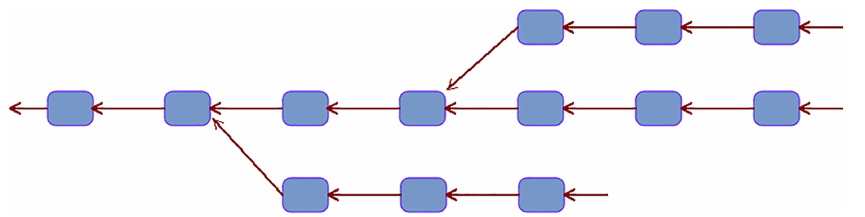
Figure 1. A pipeline of